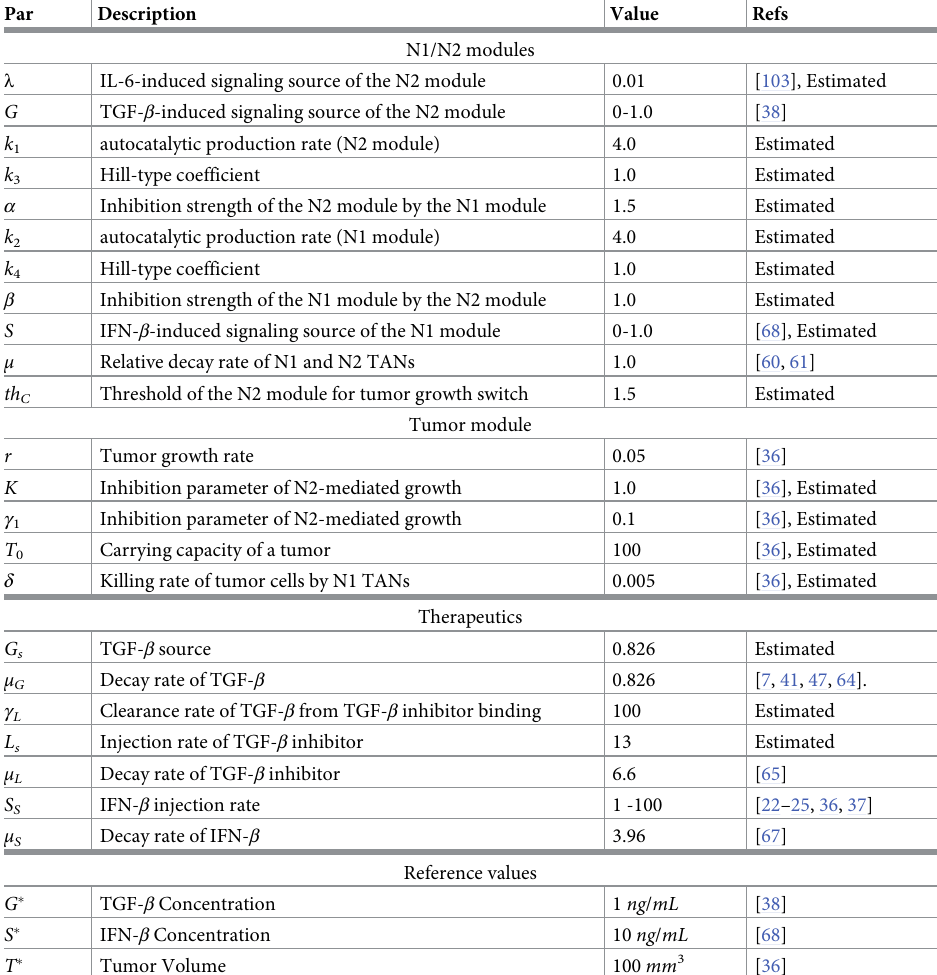
Table 2. Parameters used in the